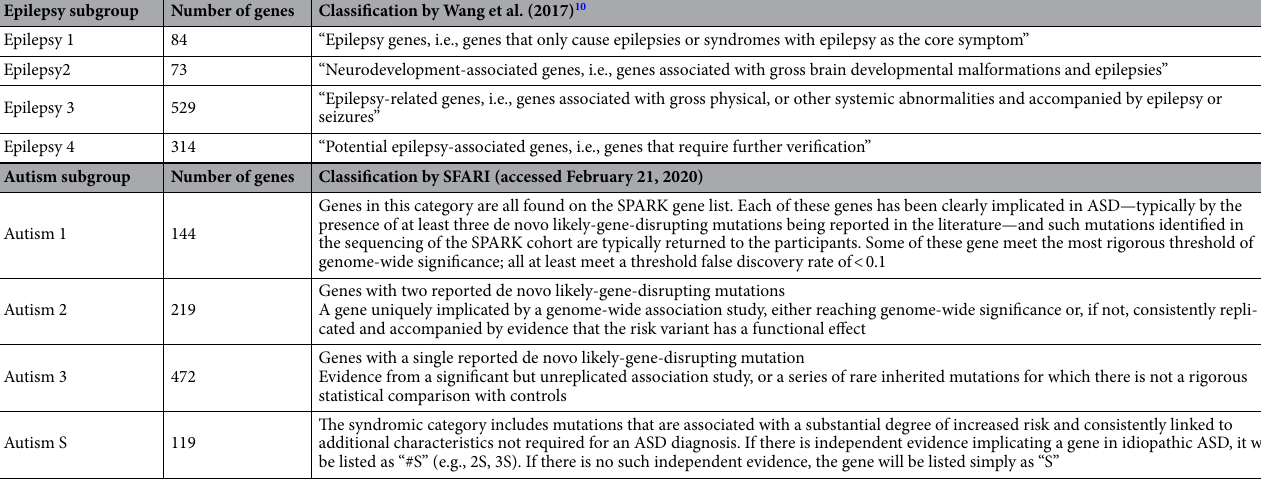
Table 1. Summary of epilepsy- and autism-associated genes used in the current study. Gene clusters from the original epilepsy and autism gene lists were separated into individual genes and gene symbols were standardized; the counts shown were taken after this